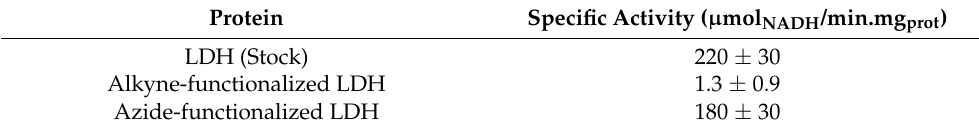
Table 3. Comparison of the specific activities of LDH functionalized with either NHS-alkyne or NHS-azide. The specific activity of the protein before being functionalized is also